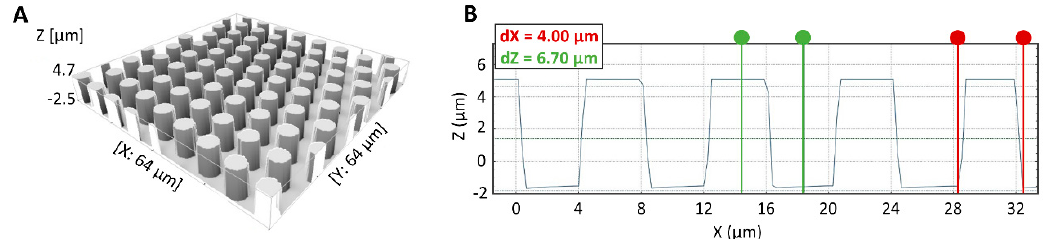
Figure 4. ( A ) 3D image of a silicon micropillar mold. ( B ) 2D section of silicon micropillar mold with a pillar of 4.00 µ m in diameter at their bottom (indicated in red) and 6.70 µ m on average height (indicated in green) after the sonication process in acetone.